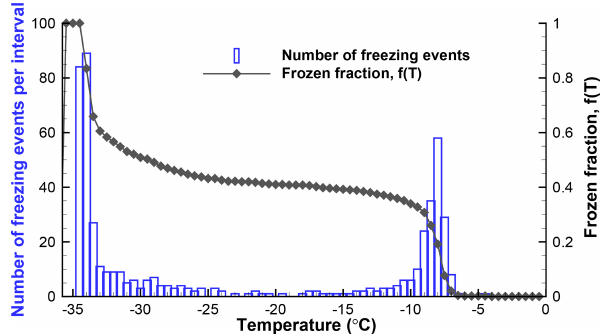
Figure 4. Differential and cumulative spectra for data discussed in Sect. 5 and displayed in different forms in Figs. 2 and 3. Zeros in the differential spectrum are seen in these plots by larger gaps between adjacent points. The left and right ordinate scales are identical. As mentioned in the text, the cumulative curve starts at a lower value than the differential because the differential is expressed with refer- ence to full degree